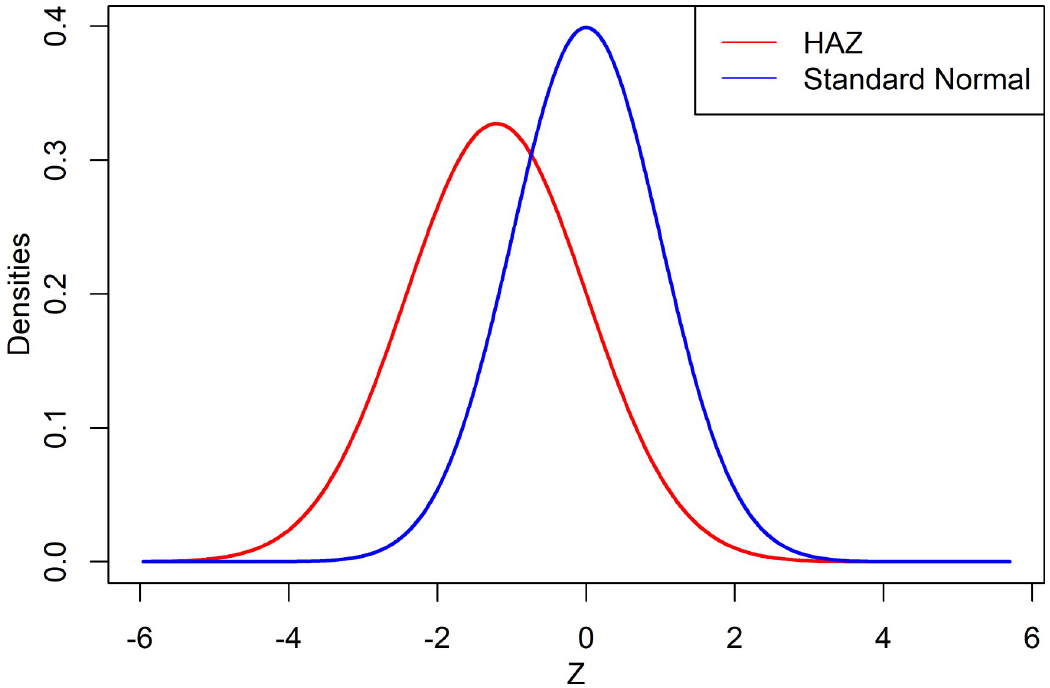
Fig 1. Density plot of the height–for–age (HAZ) Z–scores and the standard normal